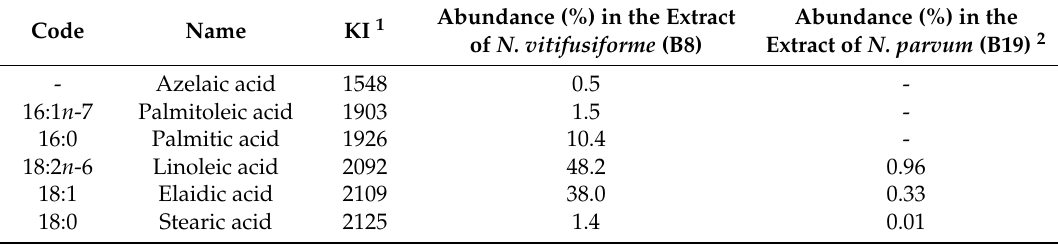
Table 2. Quantitative results of compounds in the extract of the strain B8 of N. vitifusiforme and of the strain B19 of N. parvum .